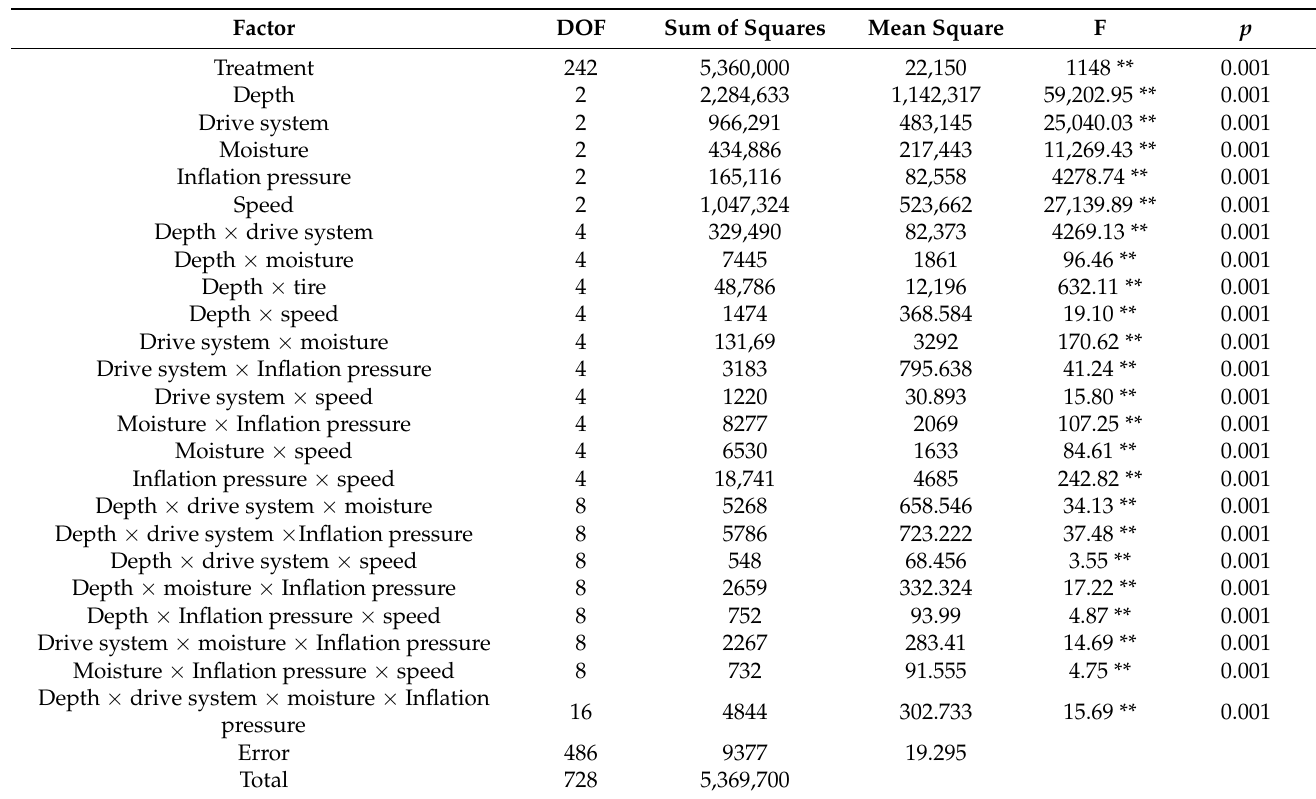
Table 2. ANOVA statistics for the effect of moisture, speed, inflation pressure, motion system and depth on soil density. Factor DOF Sum of Squares Mean